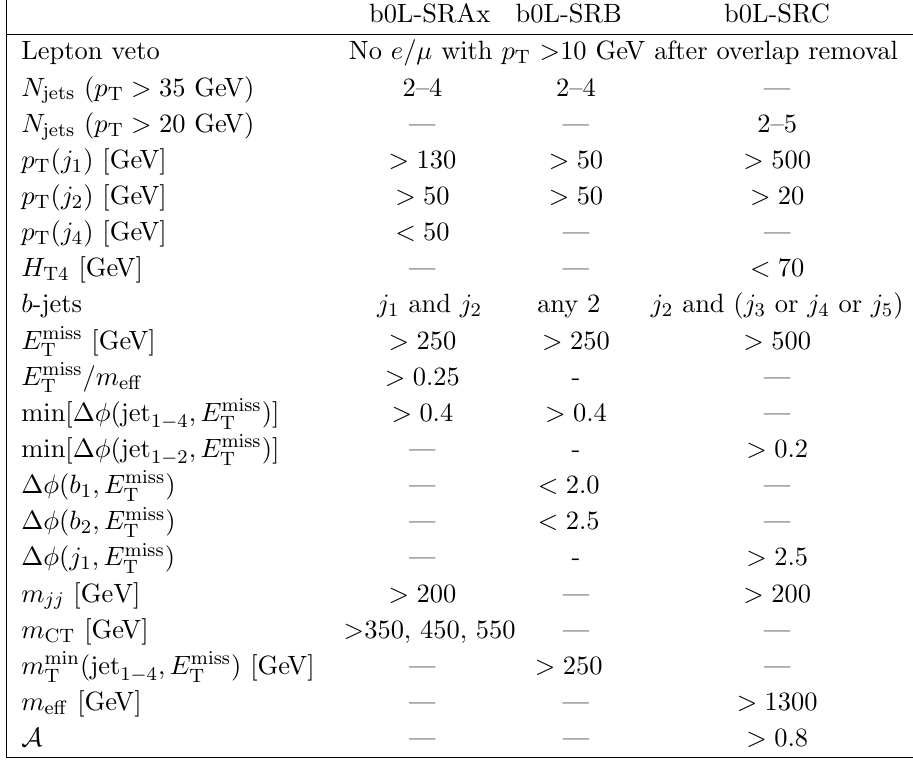
Table 1. Summary of the event selection in each signal region for the zero-lepton channel. For SRA, the \x" denotes the m CT selection used. The term lepton is used in the table to refer to baseline electrons and muons. Jets ( j 1 , j 2 , j 3 , j 4 and j 5 ) are labelled with an index corresponding to their decreasing order in p T